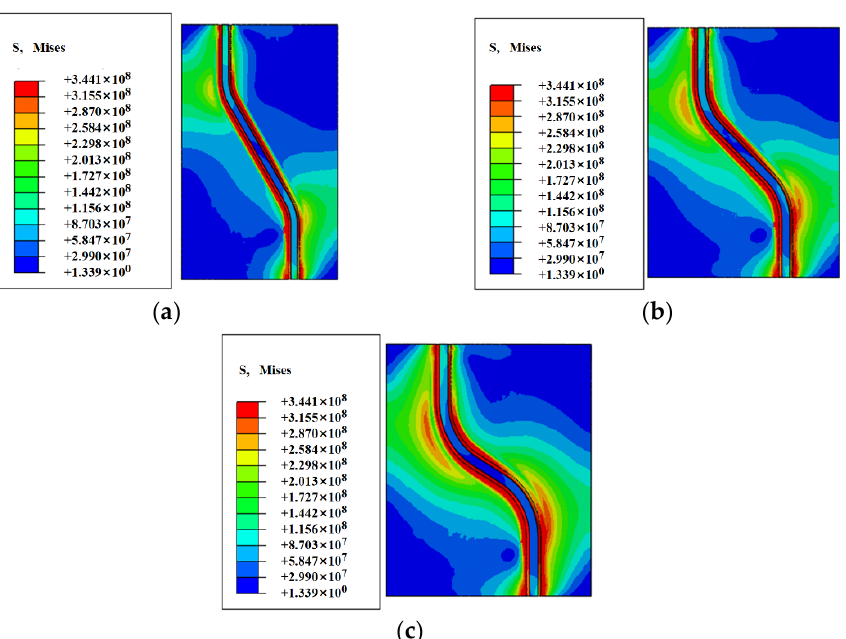
Figure 15. Stress field contour plot in welding stage (Unit: Pa); ( a ) Stress field at 20 s (30°); ( b ) Stress field at 20 s (45°); ( c ) Stress field at 20 s (60°).